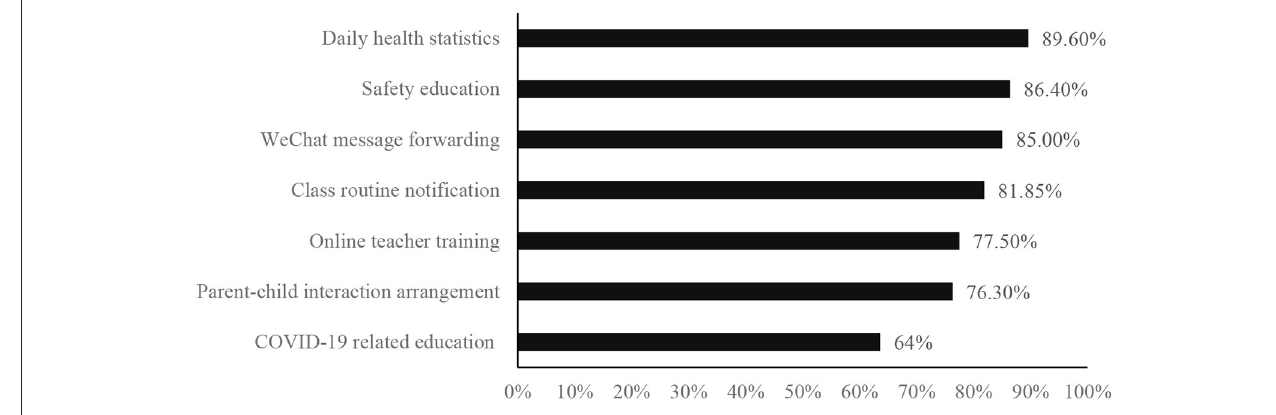
FIGURE 2 | Pre-school teachers’ work context during the COVID-19 epidemic.